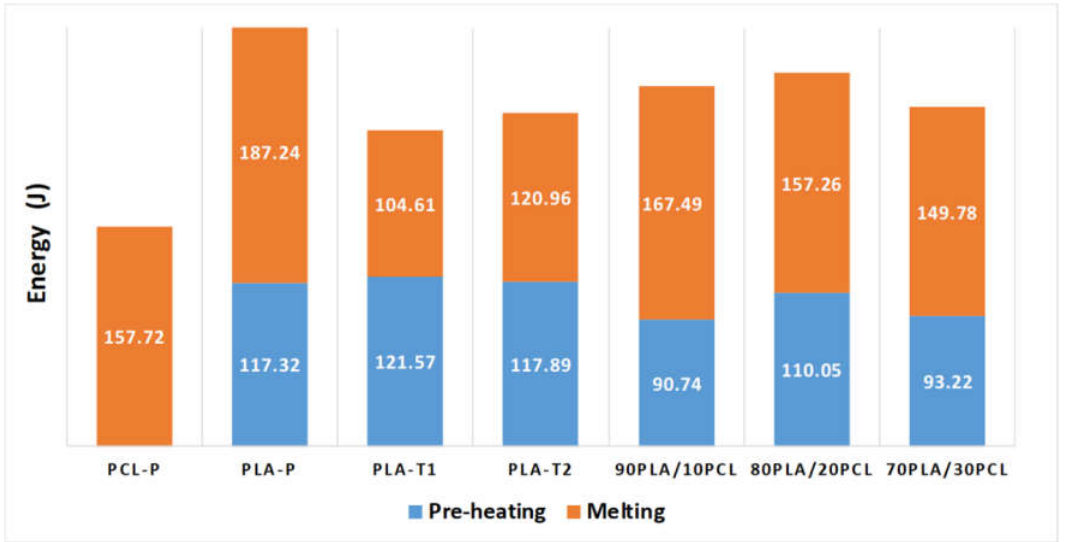
Figure 4. Ultrasonic energy for manufacturing the specimens.